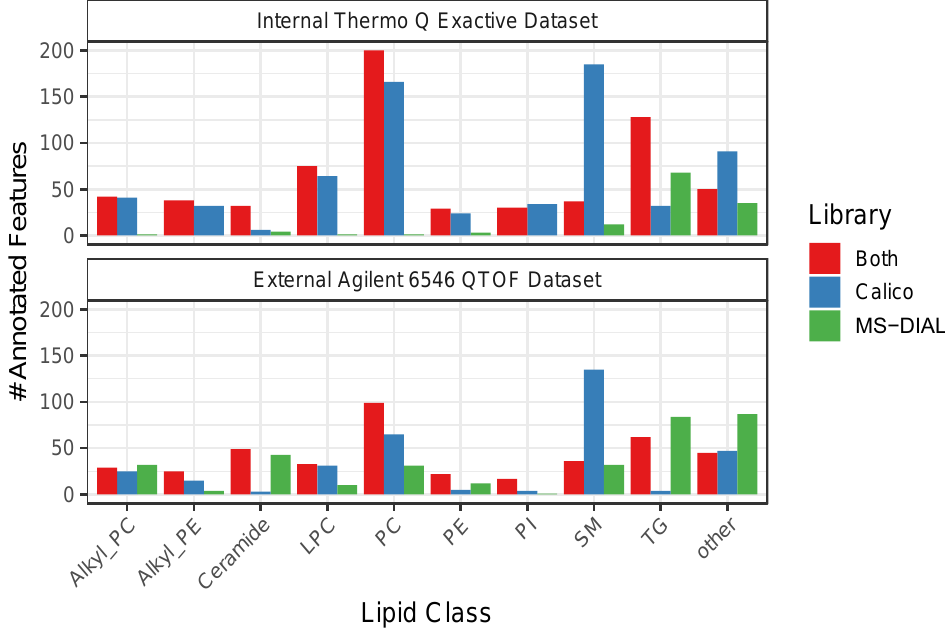
Figure 4. Summary of identified lipids by lipid class, dataset, and library. Counts of annotated features organized by lipid class, instrument dataset, and in-silico library. “Both” refers to features annotated as the same class by both CalicoLipids and MS-DIAL libraries. “Calico” and “MS-DIAL” refer respectively to features annotated exclusively by one library. The ten most commonly annotated classes are shown, along with all other classes represented in the “other” category. For example, the CalicoLipids library identifies many more SMs in both the internal Thermo and external Agilent datasets (SM, blue, upper and lower plots), while MS-DIAL identifies more TGs in the external Agilent dataset (TG, green lower plot).